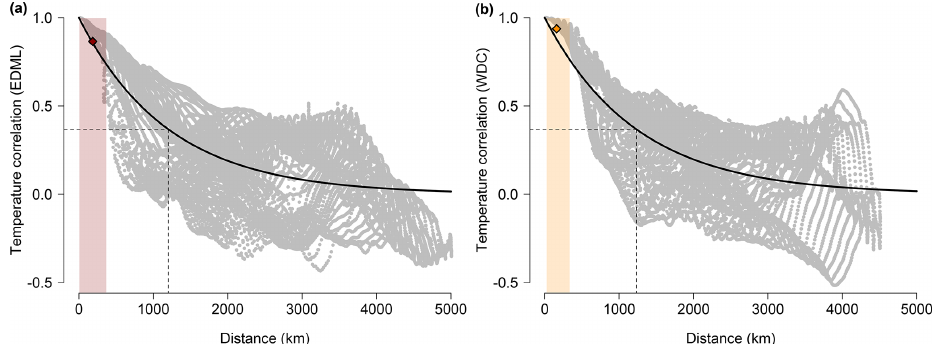
Figure C1. Present-day temperature decorrelation across DML and WAIS. Shown are the correlations (grey dots) of ERA-Interim annual- mean temperatures (Dee et al., 2011) at (a) EDML and (b) WDC with all other grid boxes below 60 ◦ S. Black lines show an exponential fit to the data; dashed lines indicate the point at which the correlations in the model have dropped to 1 /e – at 1202(1232)km for EDML (WDC). Coloured shading indicates the range of site distances of the studied firn-core arrays (Table 1); the average correlation across each range is marked by the filled diamond – average correlation of 0 . 87 (0 . 94) for EDML